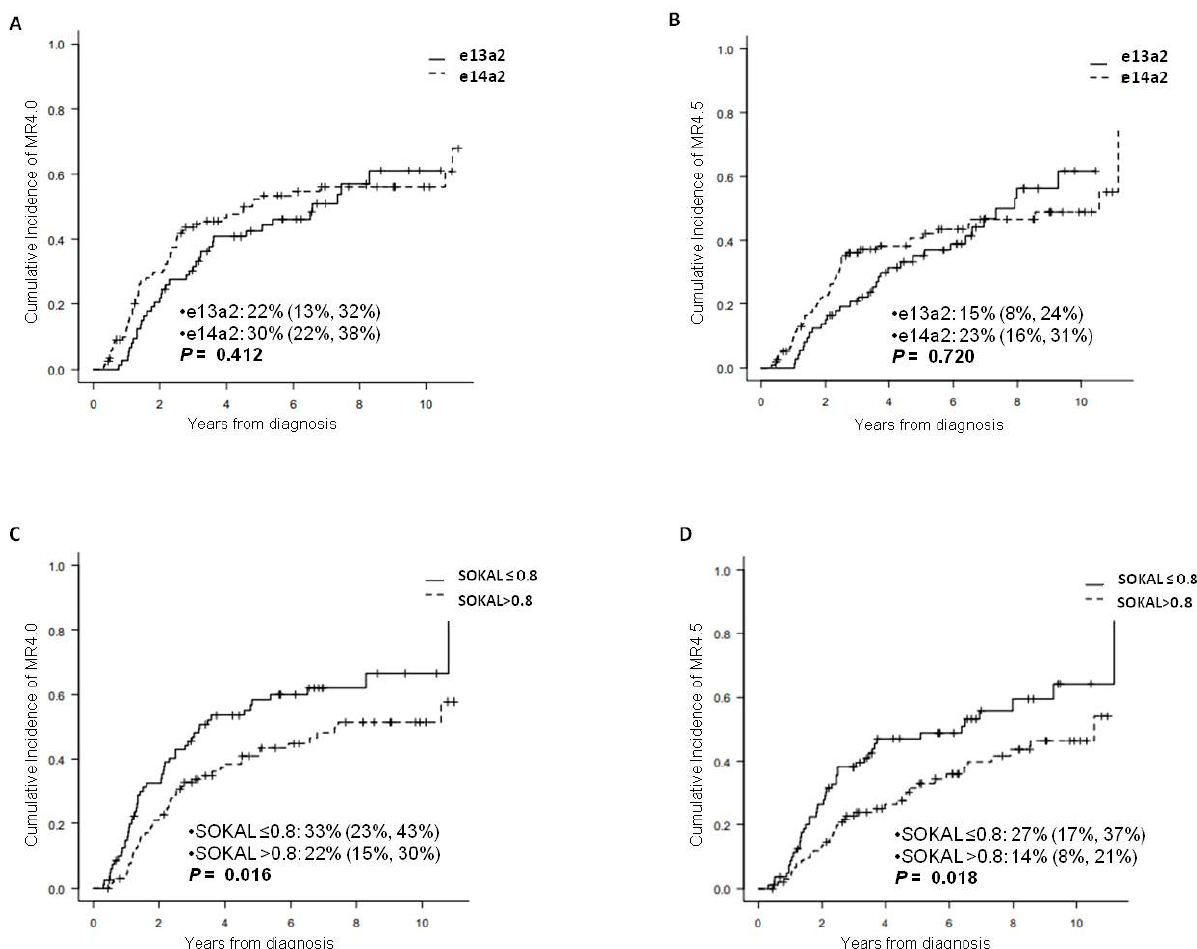
Figure 2. Cumulative incidence of deep molecular response 4.0 and 4.5 according to the transcript type (( A ) and ( B )) and according to Sokal score (( C ) and ( D )) at 2 years, respectively.